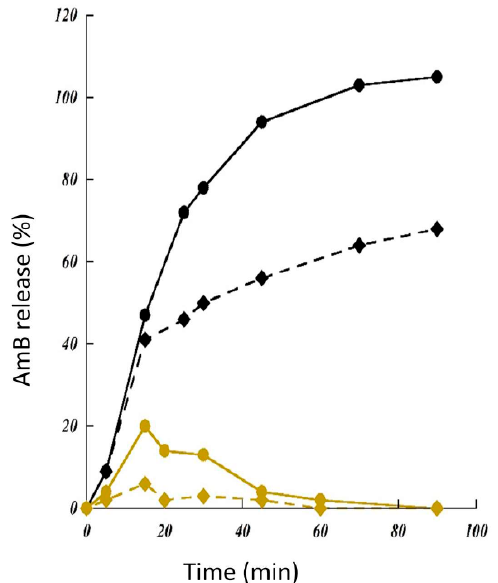
Figure 8. In vitro release profiles of amphotericin B (AmB) in gastric (gold, pH = 1.2) or pulmonary media (black, pH = 7.4). Drug was in free form (lozenges) or contained in solid dispersions based γ -cyclodextrin polymers (filled circles).